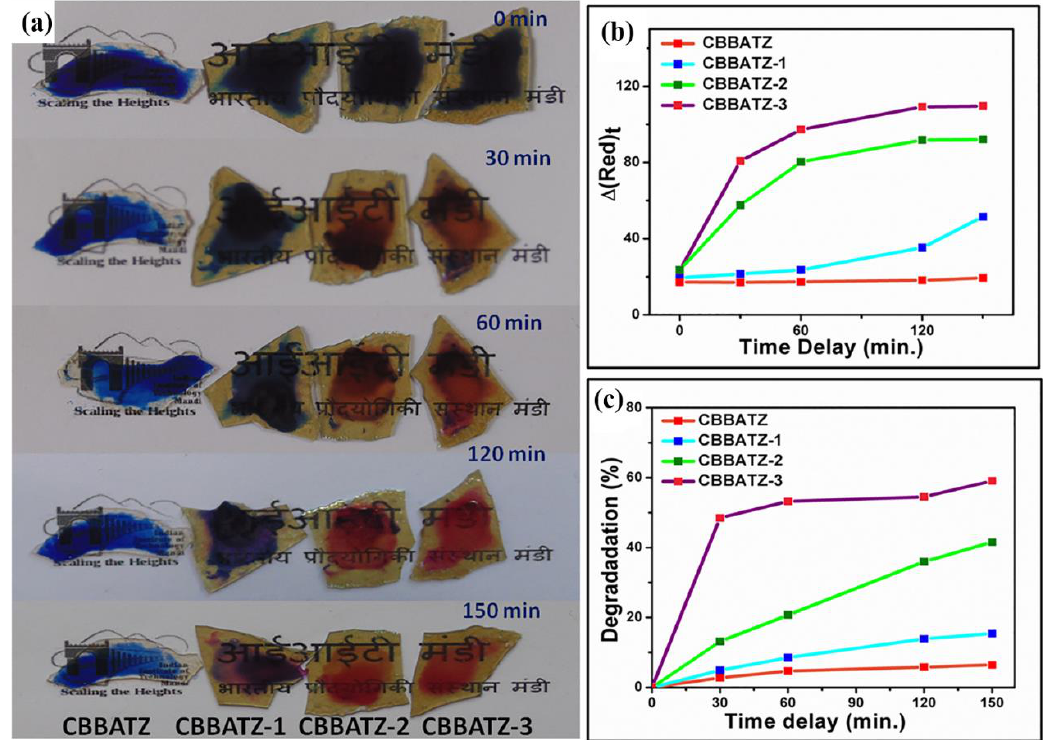
Figure 5. ( a ) Digital photographs of CBBATZ, CBBATZ-1, CBBATZ-2 and CBBATZ-3 samples at time t = 0, 30, 60, 120 and 150 min during an ink test. ( b ) C t /C 0 vs. time plot for all samples. ( c ) Percentage degradation in absorbance of MB dye with time for all samples. Reprinted with permission from Ref. [44].